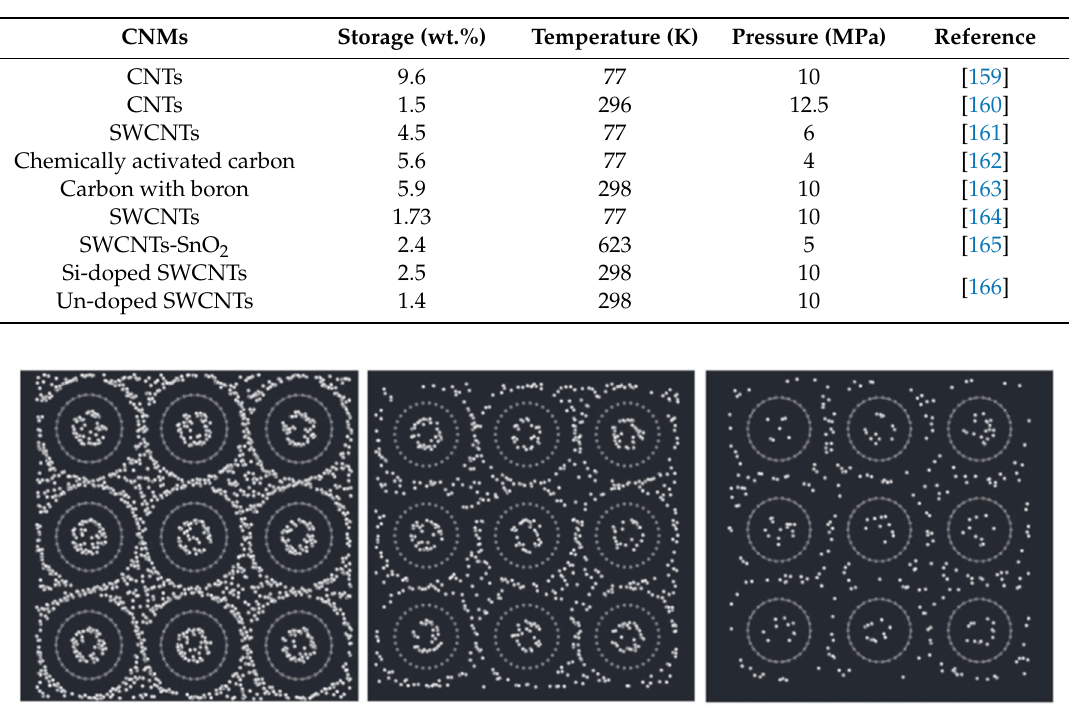
Table 9. Hydrogen storage e ffi ciency of di ff erent kinds of CNMs at di ff erent conditions.